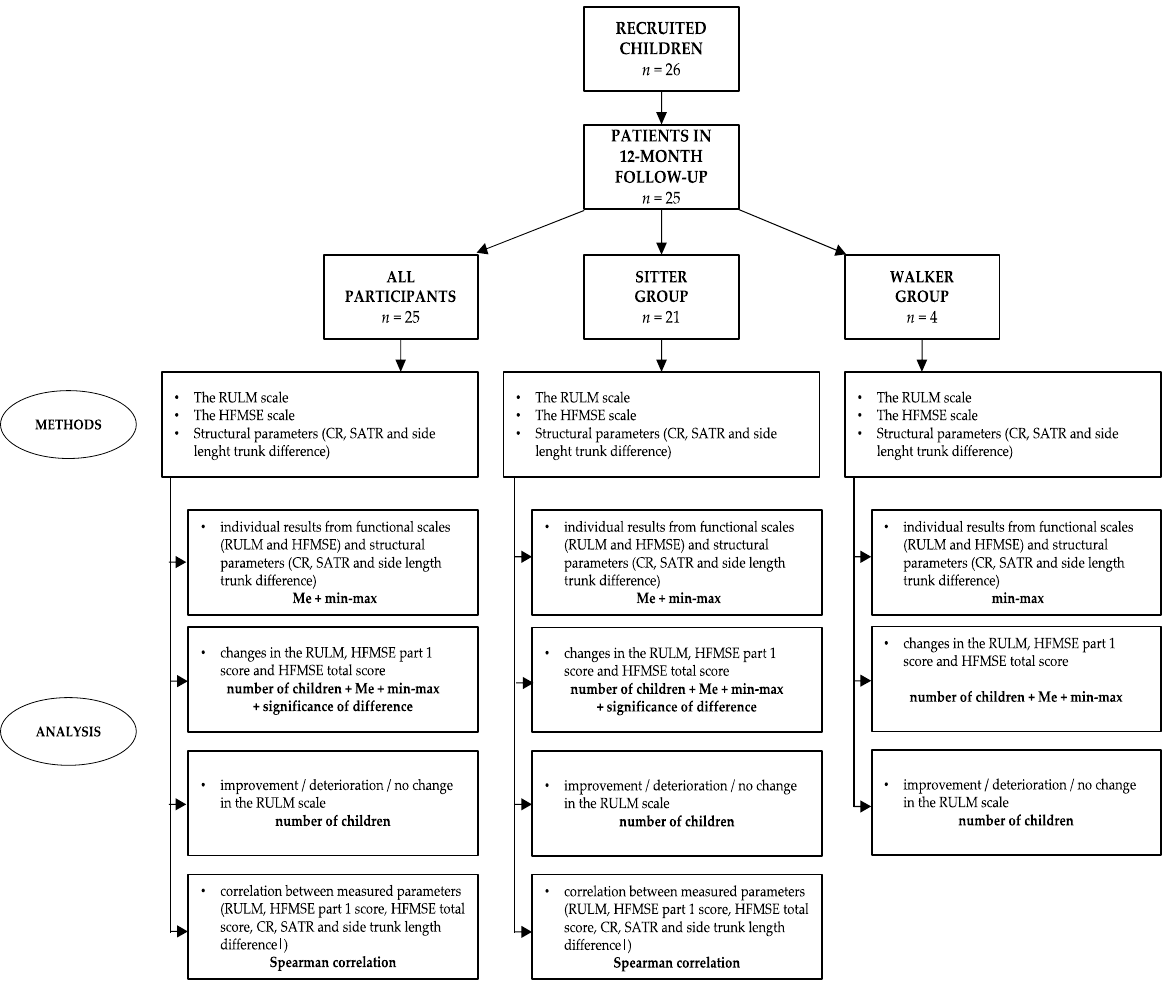
Figure 1. Flowchart with the applied methods and analysis.